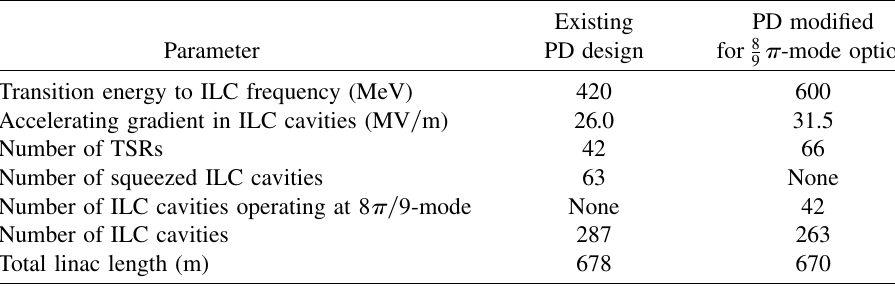
TABLE II. Main parameters of the existing and modified PD linac designs.